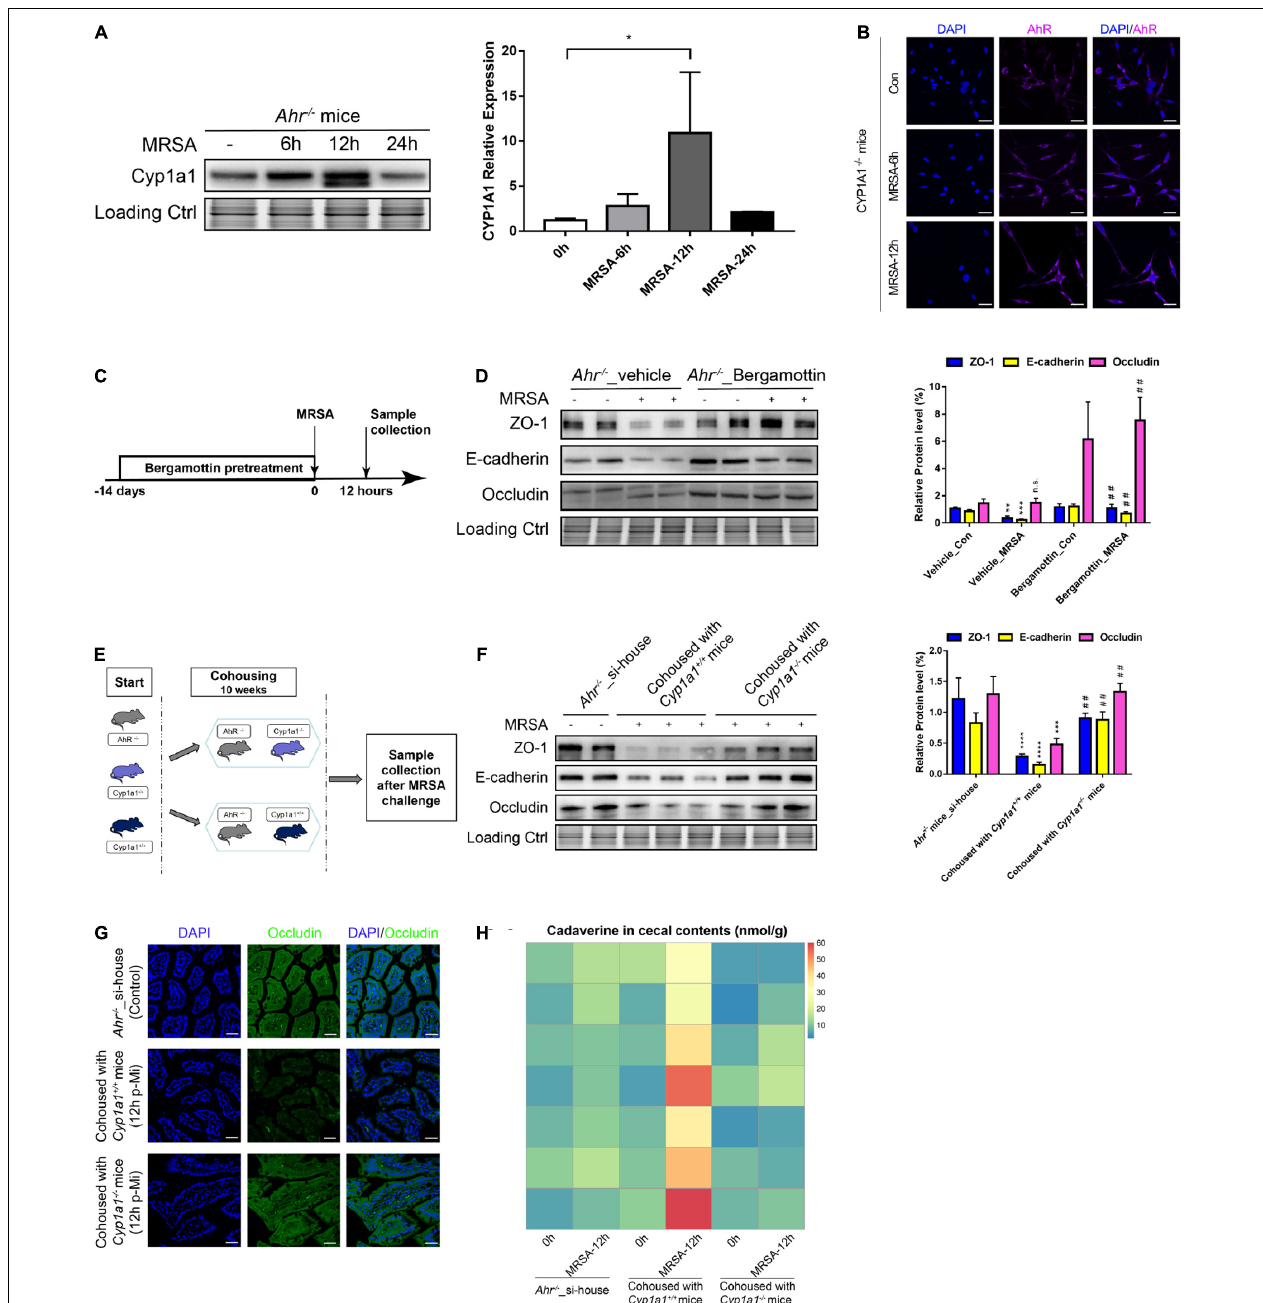
FIGURE 7 | Gut barrier function induced by commensal bacteria in an AHR-independent manner. (A) Immunoblot and densitometry plots of MRSA-induced CYP1A1 levels in the ileal epithelium from Ahr − / − mice ( n = 5–6). (B) Representative immunostaining of IEC AHR (purple) and DAPI (blue) from Cyp1a1 − / − mouse ileum before (Control; Con) or 6 h (MRSA-6h) and 12 h p-Mi (MRSA-12h). (C) Experimental design. Ahr − / − mice were fed bergamottin for 14 days before the MRSA challenge. Ileum mucosa collection at 12 h p-Mi for immunoblotting. (D) Immunoblot and densitometry plots of cell junction proteins in the ileal epithelium from Ahr − / − _Vehicle mice ( n = 7–8) or Ahr − / − _Bergamottin mice ( n = 7–8). (E) Experimental design. Ahr − / − mice were cohoused with Cyp1a1 + / + mice and Cyp1a1 − / − mice before MRSA challenge for 10 weeks. Sample collection at 12 h p-Mi. (F) Immunoblot and densitometry plots of cell junction proteins in the ileal epithelium from Ahr − / − _si-house mice ( n = 7–8), Ahr − / − mice cohoused with Cyp1a1 + / + mice ( n = 8–10) or Ahr − / − mice cohoused with Cyp1a1 − / − mice ( n = 8–10). (G) Immunofluorescence staining of ileum sections for occludin (green) and DAPI (blue) from each group. Scale bar: 40 µ m. (H) Heatmap of the caecal contents from each group. Error bars, ± SEM. * P < 0.05. si-house, only Ahr − / − mice were housed in a cage; cohouse, Ahr − / − mice were housed in a cage with Cyp1a1 + / + mice or Cyp1a1 − / − mice separately. Differences were analyzed using one-way ANOVA. * P < 0.05, ** P < 0.01, *** P < 0.001, **** P < 0.0001, n.s., not significant. ## Comparison between Ahr − / − _Vehicle-MRSA and Ahr − / − _Bergamottin-MRSA groups, or Ahr − / − mice cohoused with Cyp1a1 + / + mice and Ahr − / − mice cohoused with Cyp1a1 − / − mice. ## P < 0.01.